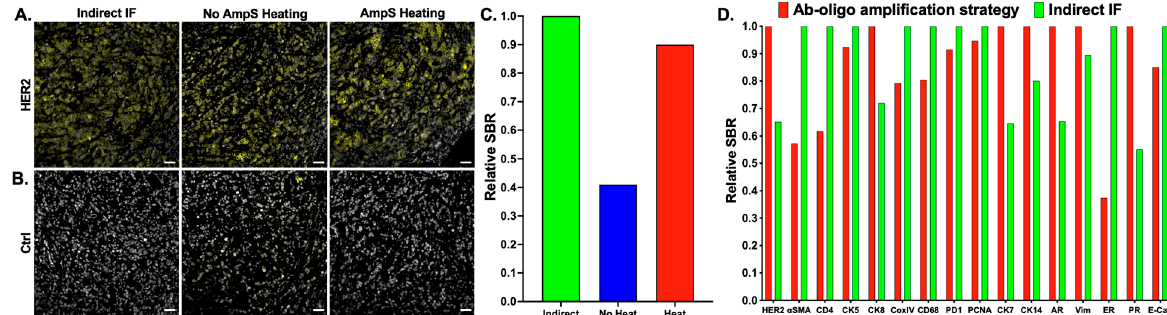
Figure 4. Amplification strand (AmpS) heating. ( A ) MCF7-HER2 xenograft FFPE tissue sections were stained with either a HER2 primary antibody for indirect IF or a HER2 Ab-oligo conjugate (HER2 = yellow and DAPI = white), where AmpS was either kept at room temperature prior to application or heated to 85 °C prior to staining. ( B ) Negative controls for each sample were stained with only a fluorophore-labeled secondary antibody or the respective AmpS staining conditions and equivalent Amp IS concentrations. ( C ) Image quantification was performed to calculate the HER2 signal-to-background ratio (SBR) for indirect IF and the Ab-oligo amplification strategy with and without heating of the AmpS prior to staining. ( D ) Indirect IF was compared to the Ab-oligo amplification strategy (20x Amp S to AmpS) using 85 ° C heating across antigens including HER2, alpha-smooth muscle actin ( α -SMA), CD4, cytokeratin 8 (CK8), CoxIV, CD68, PD1, PCNA, CK7, CK14, androgen receptor (AR), Vimentin (VIM), estrogen receptor (ER), progesterone receptor (PR), and E-Cadherin (E-Cad). Images shown are representative of multiple fields of view and quantification results are reported as a representative average of all images. Scale bar = 50 µ m.